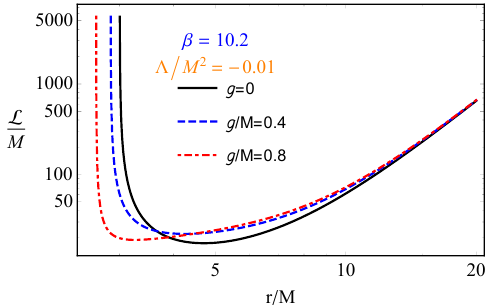
Figure 12. The specific angular momentum of the magnetized particles for circular orbits as a function of the radial coordinate for the different values of magnetic charge parameter g and the parameter β . In the top panel, the magnetic charge of the BH is fixed as g = 0.5 M , and in the bottom panel, the parameter as β =